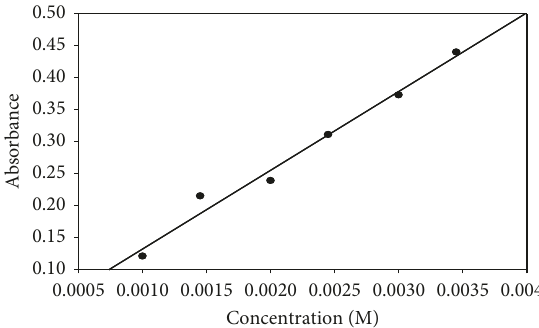
Figure 3: Plot of absorbance versus concentration of aqueous solution of adenine at 260nm, pH 7.0, and R 2